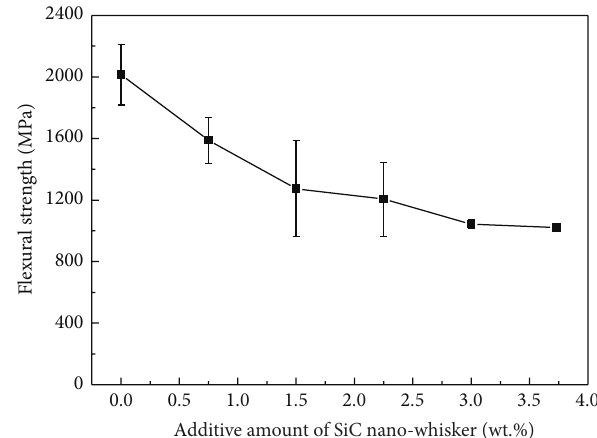
Figure5:TheVickershardnessoftheas-preparedWC-Nicemented carbides with varied fractions of SiC nanowhisker.